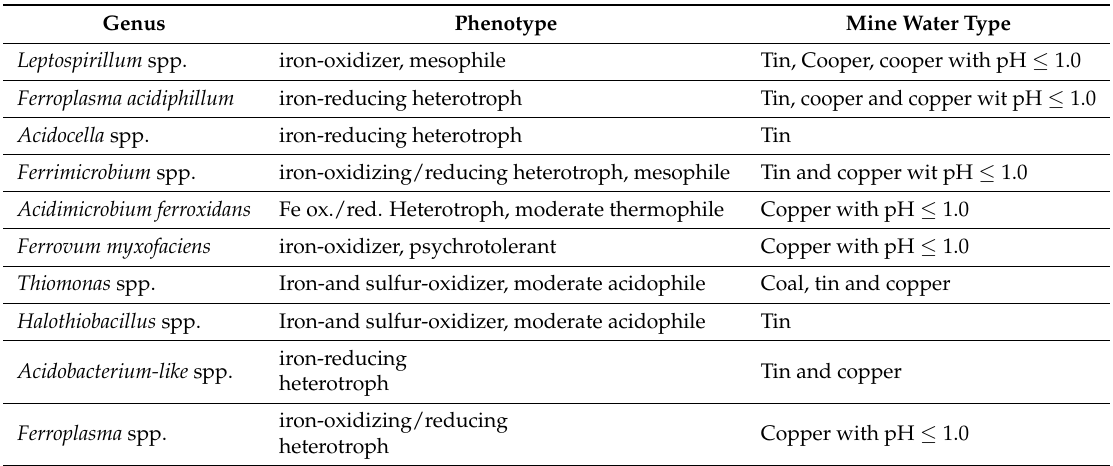
Table 3. Genus and phenotype of microorganisms isolated from different mines. Modified of [88,89]. Genus Phenotype Mine Water Type Leptospirillum spp. iron-oxidizer, mesophile Tin, Cooper, cooper with pH ≤ 1.0 Ferroplasma acidiphillum iron-reducing heterotroph Tin, cooper and copper wit pH ≤ 1.0 Acidocella spp. iron-reducing heterotroph Tin Ferrimicrobium spp. iron-oxidizing/reducing heterotroph, mesophile Tin and copper wit pH ≤ 1.0 Acidimicrobium ferroxidans Fe ox./red. Heterotroph, moderate thermophile Ferrovum myxofaciens iron-oxidizer, psychrotolerant Thiomonas spp. Coal, tin and copper Halothiobacillus spp. Tin iron-reducing Acidobacterium-like spp. Tin and copper heterotroph Ferroplasma